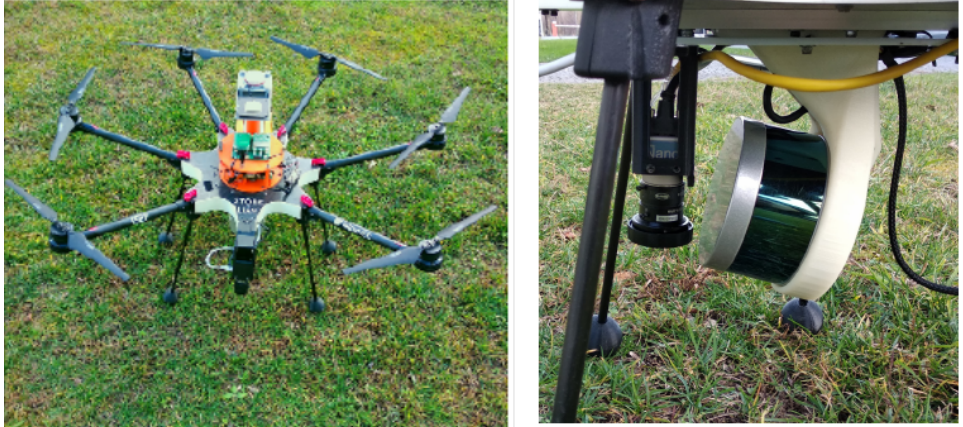
Figure 12. STORK UAV equipped with the LiDAR